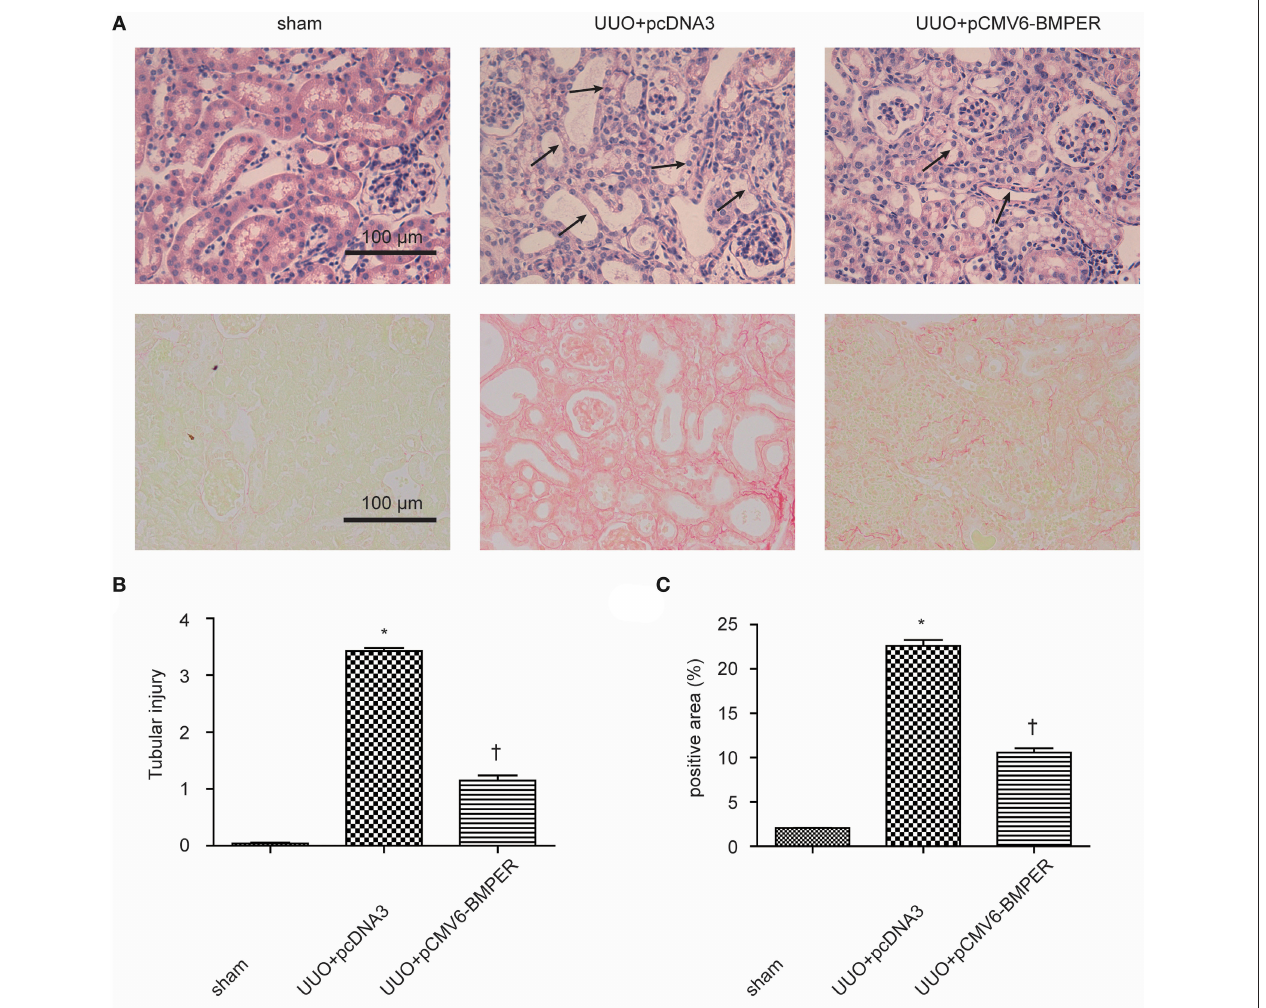
FIGURE 8 | BMPER ameliorated tubule atrophy and interstitial fibrosis. H&E staining showed BMPER ameliorated tubular injury [upper panel of (A) ]. Arrows indicated tubular atrophy. PSR staining showed BMPER decreased interstitial fibrosis [lower panel of (A) ]. Semi-quantitative analysis for tubule atrophy and interstitial fibrosis were shown in (B,C) , respectively. Scale bar = 100 µ m. Values are the means ± SEM ( n = 6). * p < 0.05 vs. sham; † p < 0.05 vs. UUO + pcDNA3.